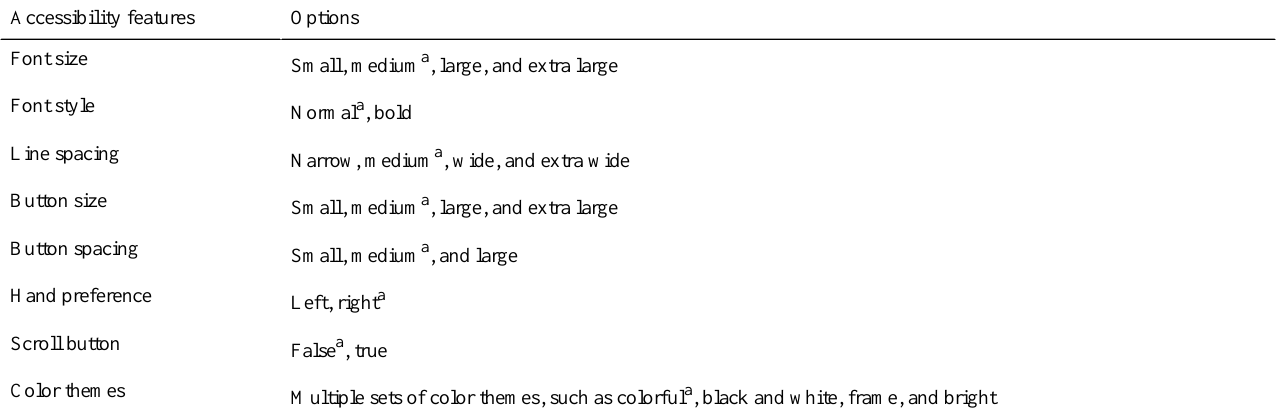
Table 3. Options for several accessibility features available in the iMHere 2.0 client